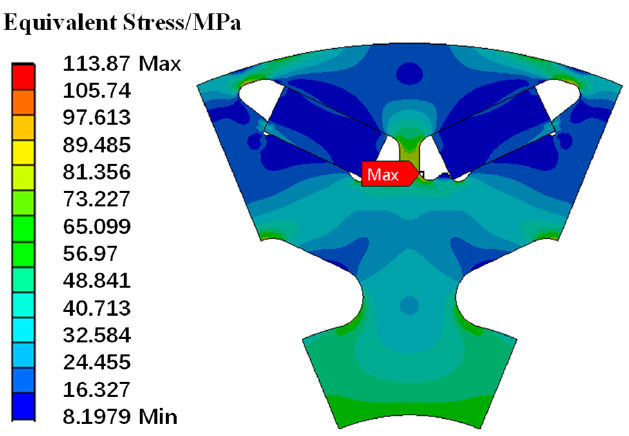
Figure 13. Rotor stress distribution under a structural field.